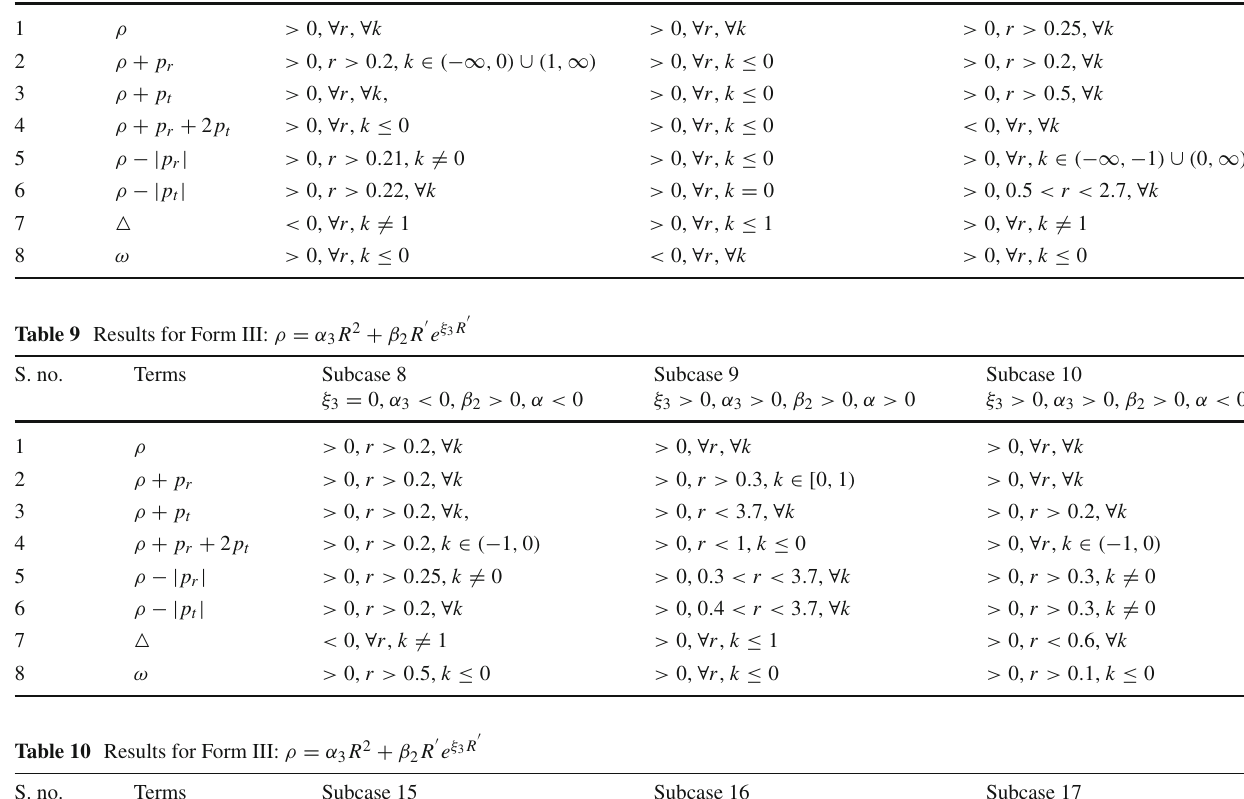
Table 8 Results for Form III: ρ = α 3 R 2 + β 2 R (cid:2) e ξ 3 R S. no.